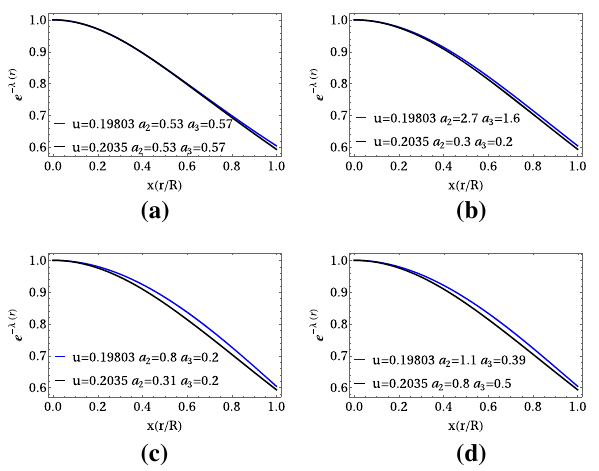
Fig. 2 e − λ for Model 1 ( a ), Model 2 ( b ), Model 3 ( c ) and Model 4 ( d )